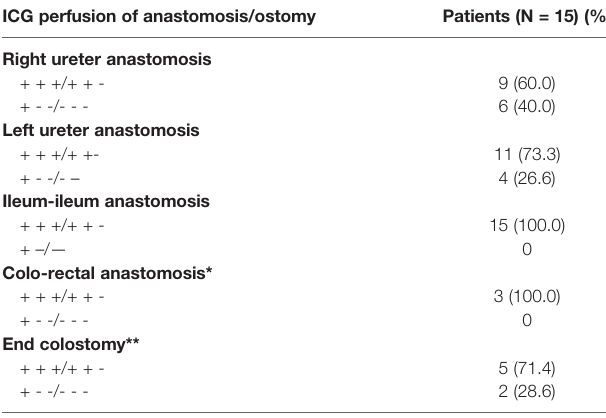
TABLE 1 | Patients ’ characteristics. Characteristic